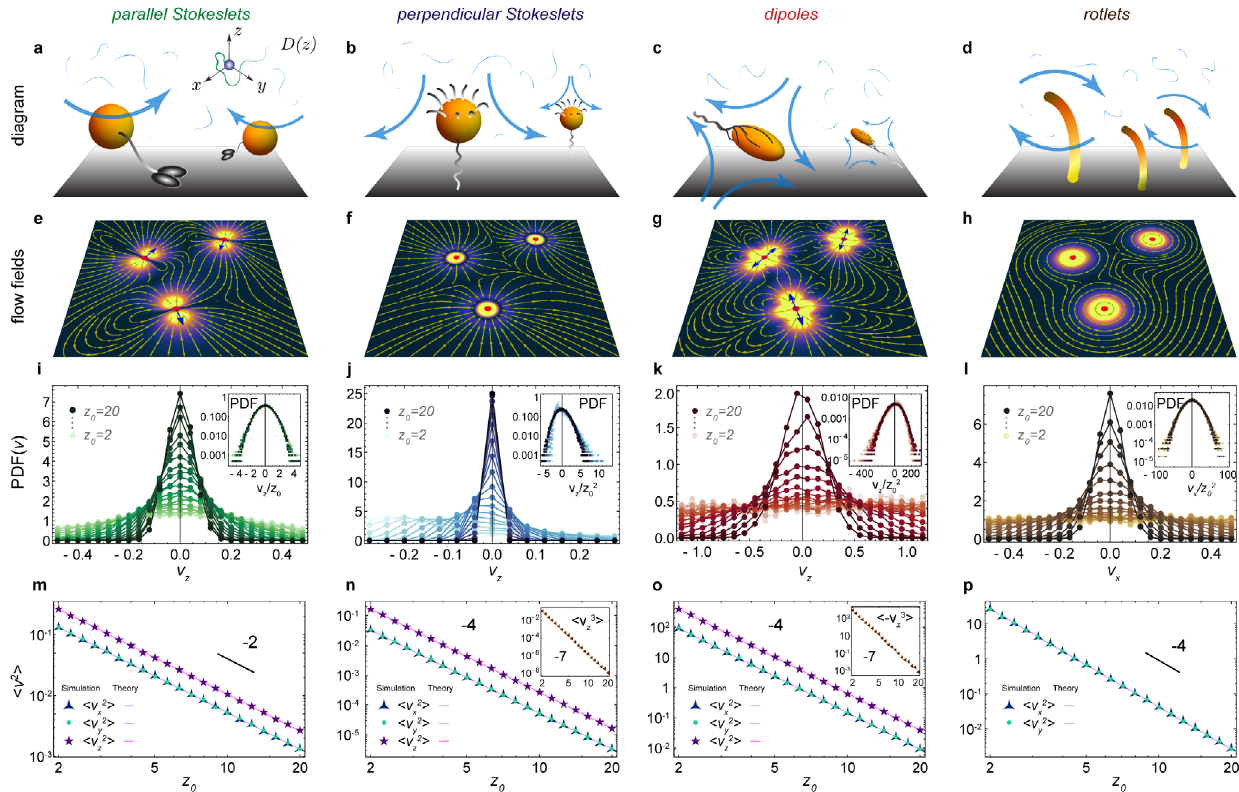
Fig. 1 Flows driven by different types of active carpets. Diagrams of a few examples: a Molecular motors walking along a surface, described by parallel Stokeslets. b Sessile suspension feeders that draw in feeding currents, described by perpendicular Stokeslets. c E. coli bacteria swimming along a surface, described by Stokes dipoles. d Actuators that rotate about the z -axis, such as nodal cilia, described by Stokes rotlets. e – h Flow fi elds generated by these different actuator types, shown in the xy plane at z 0 = 2 h . i – l Probability distribution functions, PDF( v z ), of the total fl ow velocity due to N a = 10 5 actuators, at different heights z 0 . Insets show rescaled histograms that highlight skewness and kurtosis, especially for small z 0 values. m – p The variance of these distributions, h v 2 i i , corresponding to the strength of active fl uctuations in different directions i , as a function of distance z 0 from the active carpet. Insets show the skewness for n and o , but this is zero for m and p . Symbols show simulation results and the lines are the theoretical predictions of Eq. (1) and Table